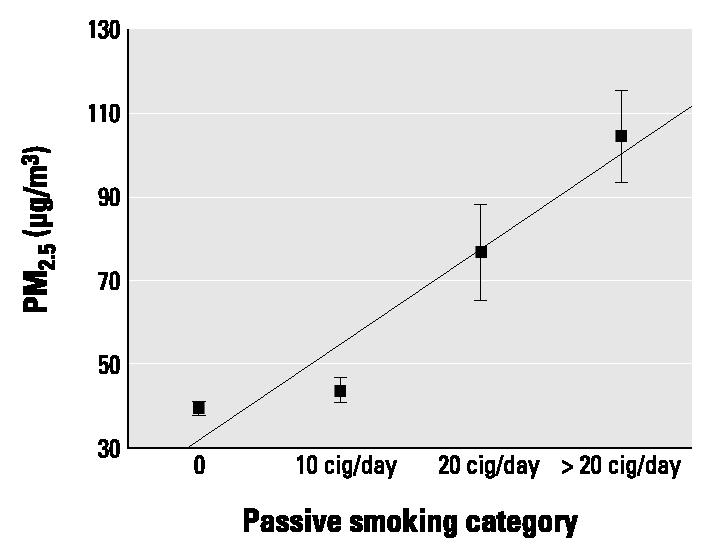
Personal PM2.5 level by passive smoking category [cigarettes (cig)/day]. Data are mean ± SE.